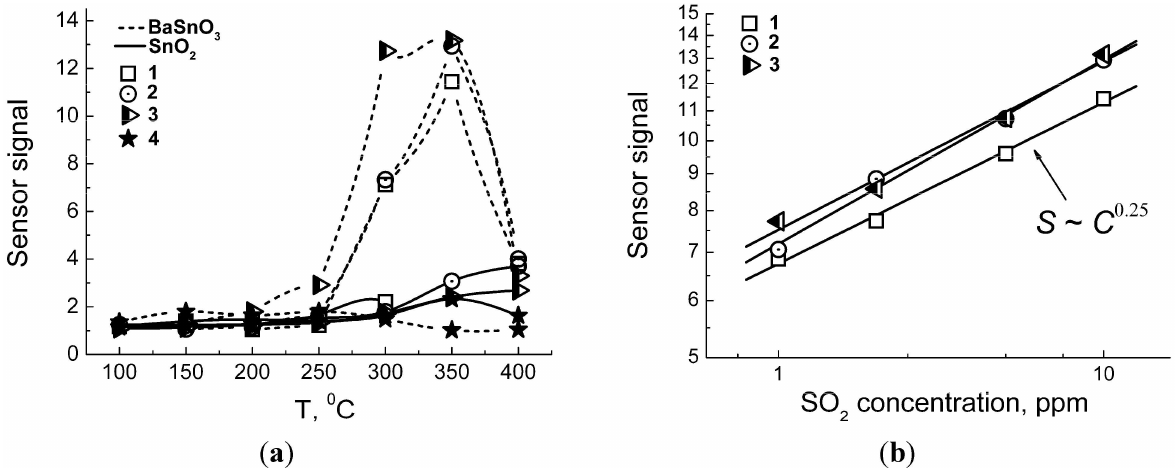
Figure 7. ( a ) Temperature dependence of sensor signals to SO and SnO samples. ( b ) Logarithmic plot of sensor signals measured at 350 ˝ C vs . 2 SO concentration for BaSnO samples annealed at different temperatures: (1) ´ 275 ˝ C, 2 3 (2) ´ 500 ˝ C, (3) ´ 700 ˝ C, and (4) ´ 1000 ˝